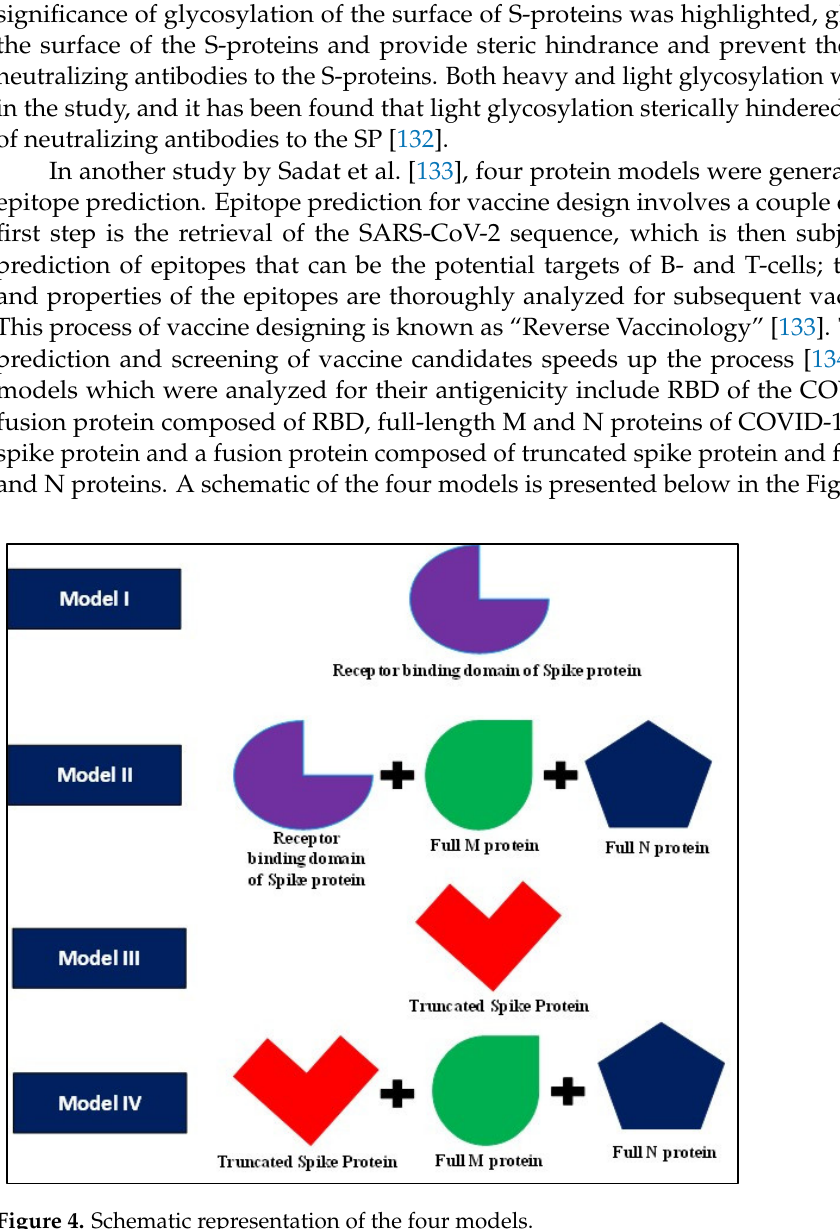
Figure 4. Schematic representation of the four models.